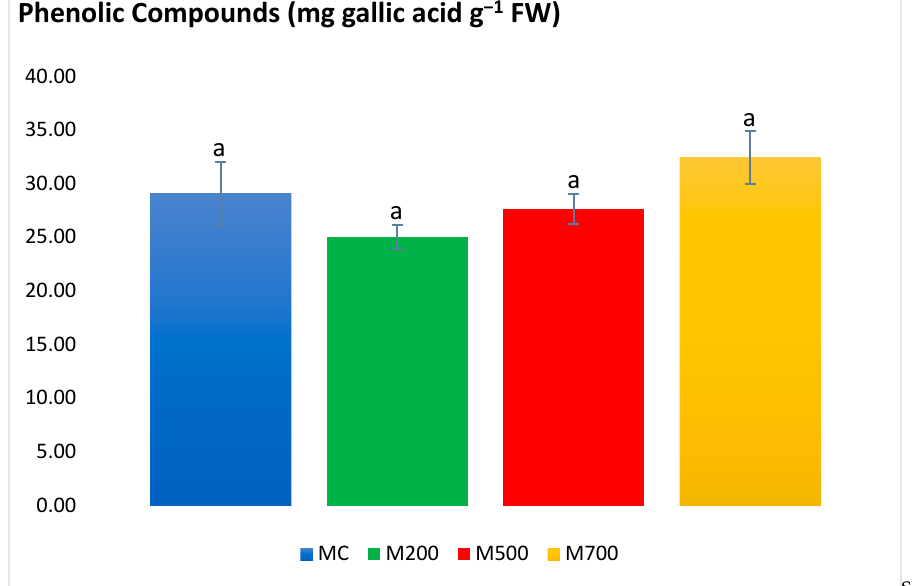
Figure 6. Concentration of phenolic compounds in the leaves of Mis-B cultivar cultivated in soils with gradient T.E. concentrations (MC, M200, M500, M700). Values are presented as mean ± SE. Di ff erent le tt ers refer to signi fi cant di ff erences between plants (Tukey HSD test, n = 6, p ≤ 0.05) . Flavonoid content (Figure 7) showed no signi fi cant di ff erences between MC and M200 (2228.18 ± 92.17 mg L − 1 catechin g − 1 FW), nor between MC and M500 (3448.89 ± 312.22 mg L − 1 catechin g − 1 FW). However, the highest value associated to M700, presented an increase by 39% compared to MC.